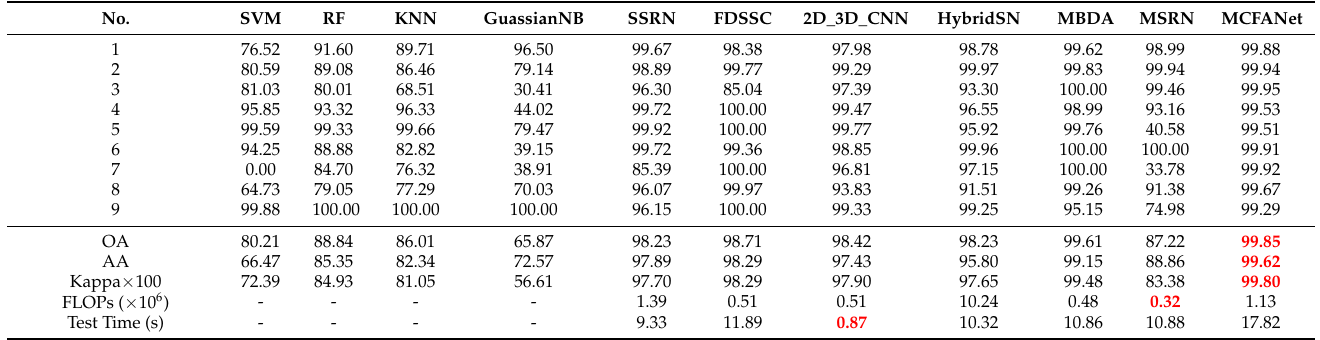
Table 4. The classification accuracies of comparison approaches on the UP dataset.